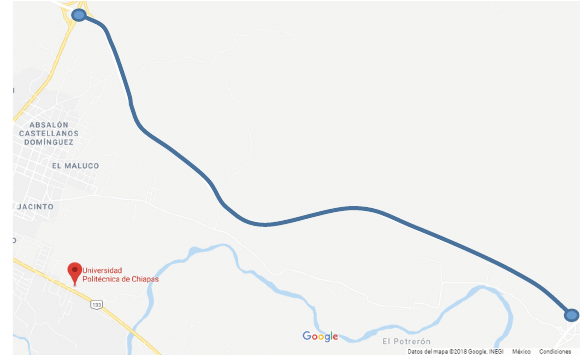
Figure 9: Minitrip